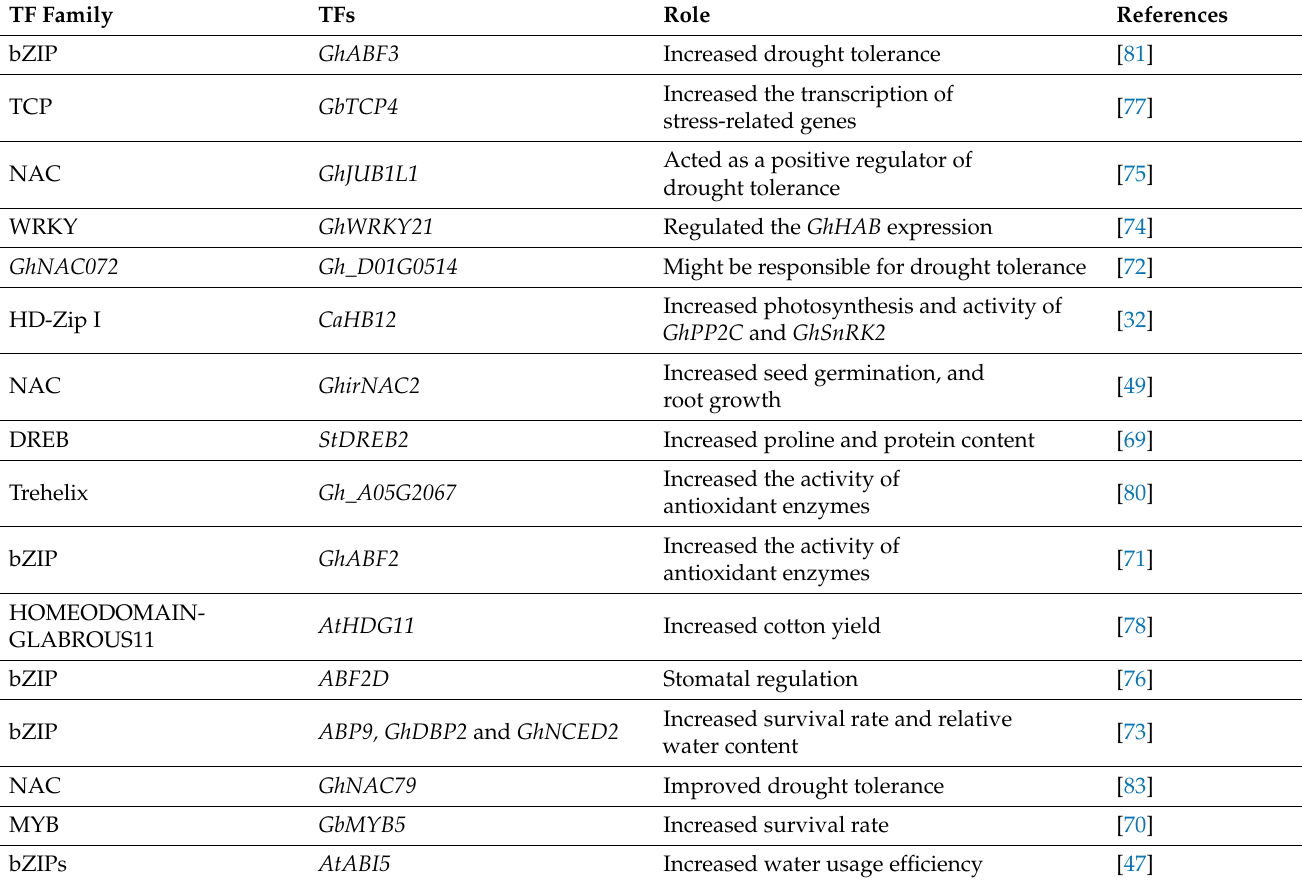
Table 3. Detailed analysis of different TFs and their role in drought tolerance in